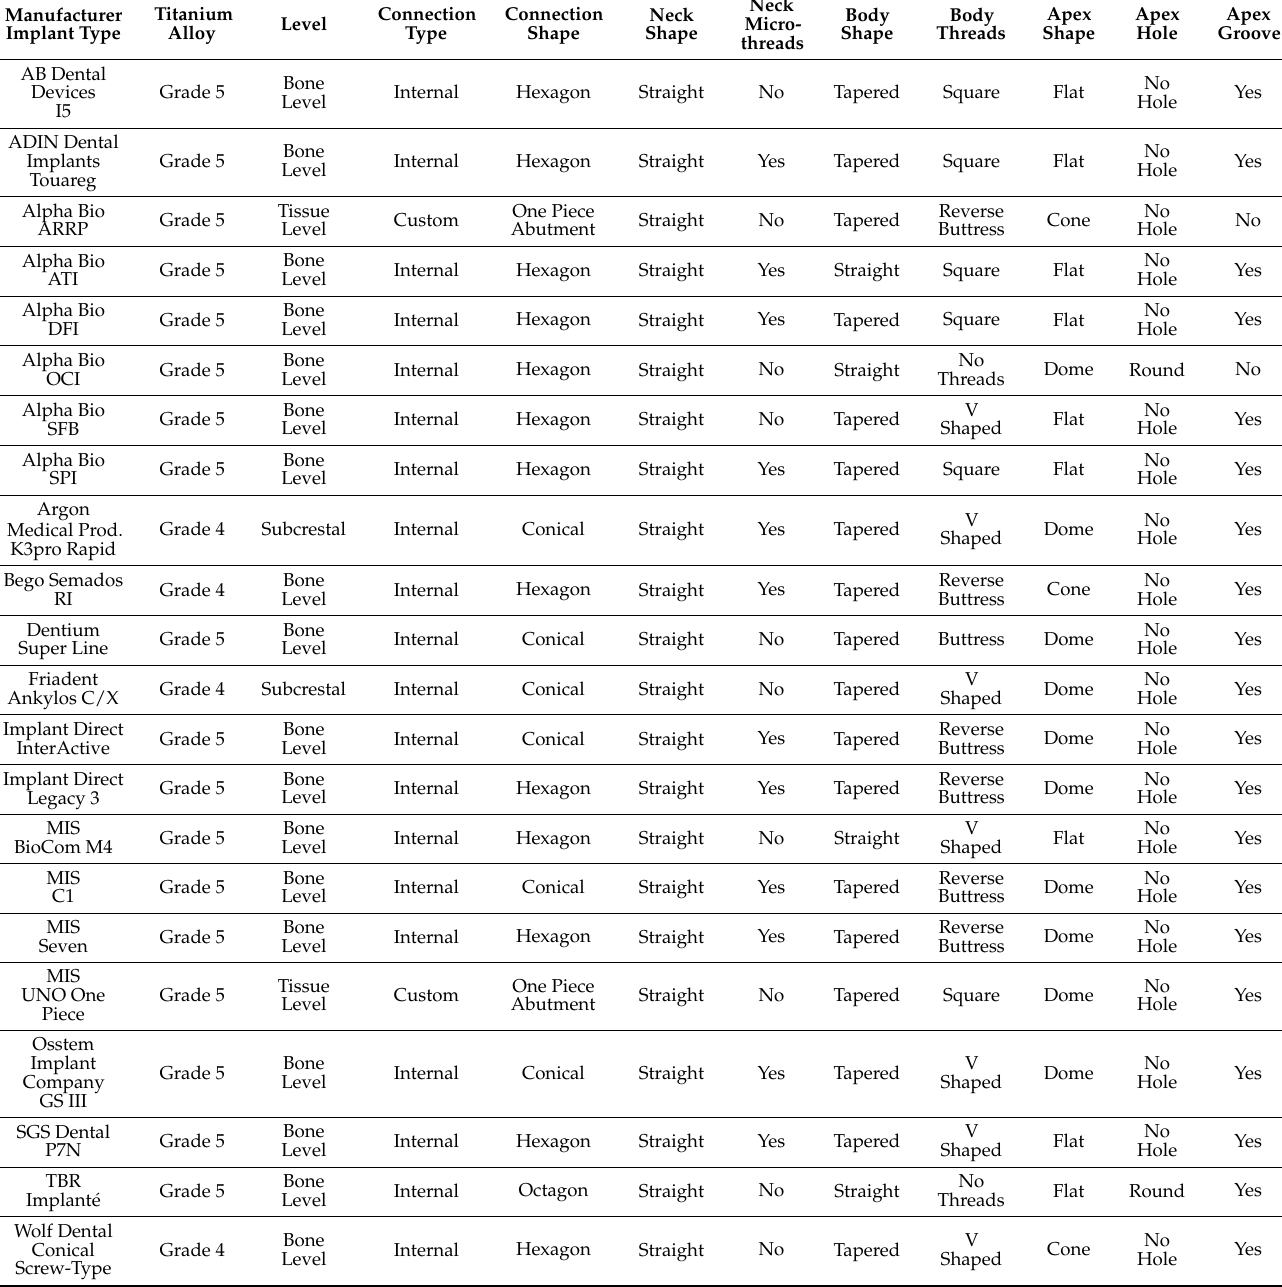
Table 1. Design features of dental implant used in this study (www.spotimplant.com/en/ (access on 21 July 2022)). Alphabetical order of the implant